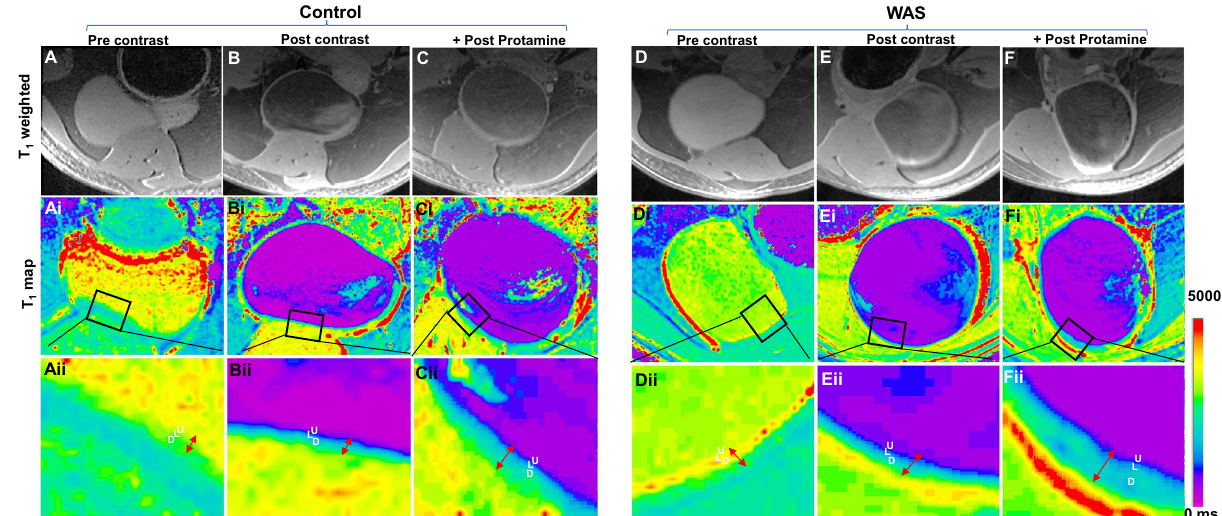
Figure 1. Effect of WAS and PS on voxel-wise T 1 mapping- T 1 weighted images (TR/TE 1410/7ms) acquired before the instillation of CM (pre-contrast), after the instillation of CM but prior to the exposure to protamine sulfate PS (post-contrast) and after PS exposure in the rat bladder from control ( A – C ) and WAS group ( D – F ). To derive the functional meaning of a slight increase in the signal intensity of WAS bladder wall, color coded, voxel-wise T 1 maps with volumetric coverage were constructed from the mono exponential fit of signal in T 1 weighted images acquired at six different TR values of 400–10,000 ms using aRARE factor of 2 and signal averages of 2. Just as the traditional histochemical stains reveal the biochemical differences between tissue layers, the color-coded T 1 maps with the resolution of 50 µm for each pixel after zero filling displays the three individual layers of mucosa (U), lamina propria (L) and detrusor (D) in bladder wall differentiated by the physical parameter of T 1 relaxation time mapped to voxels sized 0.1 × 0.1 × 0.7 mm 3 . The relative ingress of extracellular T 1 shortening agent, Gadobutrol in the post-contrast T 1 maps expanded the spatial separation between pixels displaying the layers of U and L ( Eii vs Bii ) and predicted an expansion of extracellular space in L of WAS group compared to controls. The spatial separation between U and L of WAS group increased further after a brief PS exposure ( Fii vs Cii